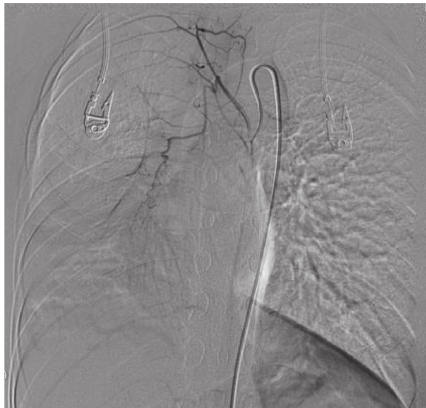
Figure 3: Angiography showed that the right lower bronchial artery had the same origin as the left bronchial artery, and the vascular lumen was dilated. The right lower lung branches were disorganized, with a small amount of light staining in the parenchymal phase.